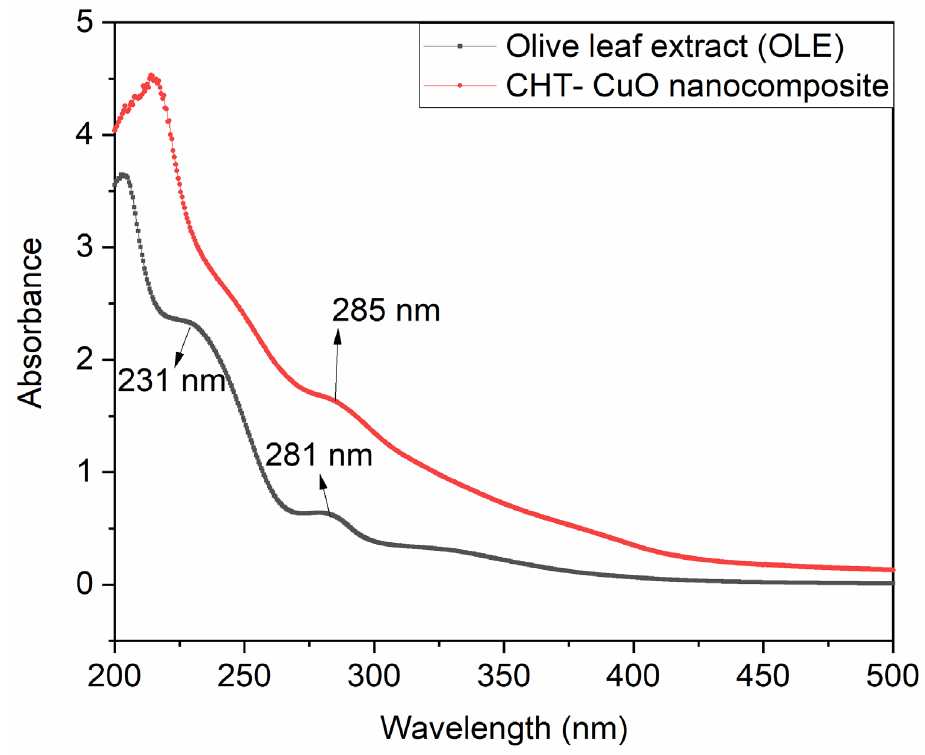
Figure 2. UV-vis spectra of OLE and CHT − CuO nanocomposite.